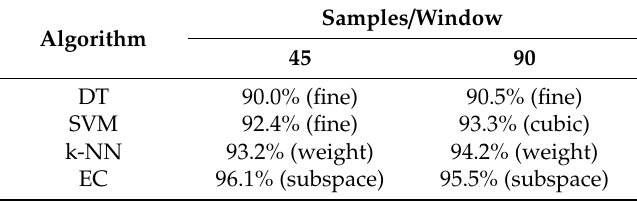
Table 1. Accuracy performance of the algorithms classifying rest and e ff ort events *